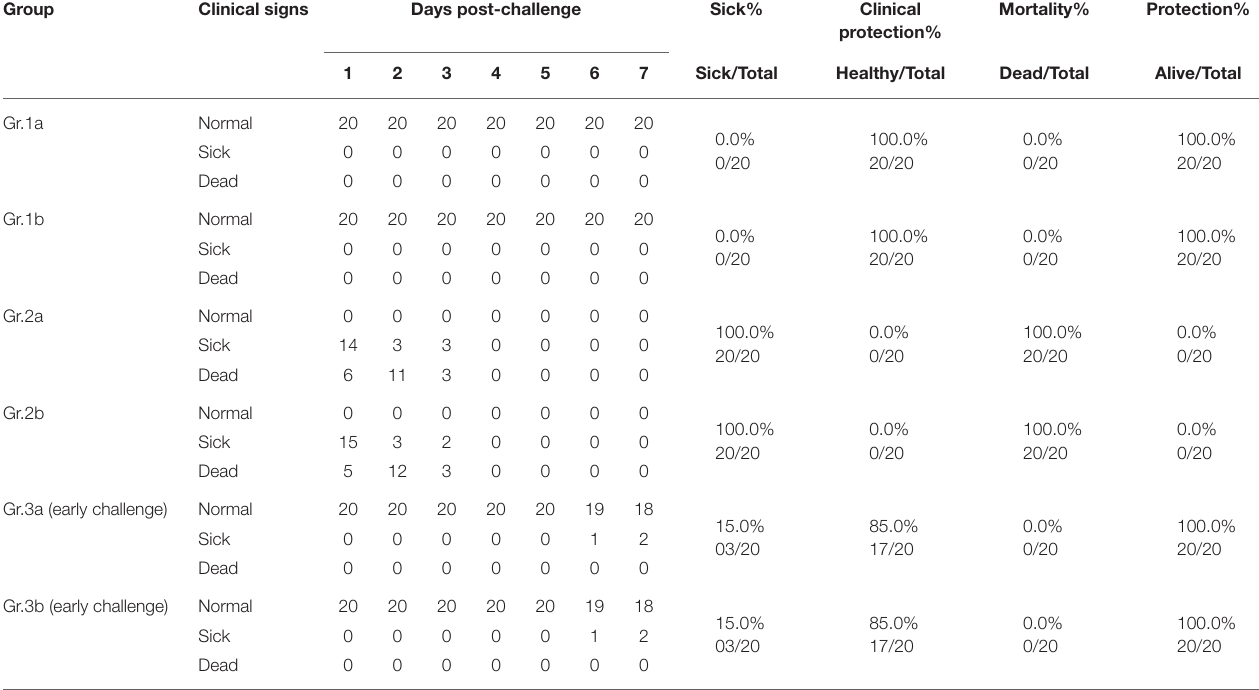
TABLE 3 | Experiment 1 (early challenge) protection results. Group Clinical signs Days post-challenge